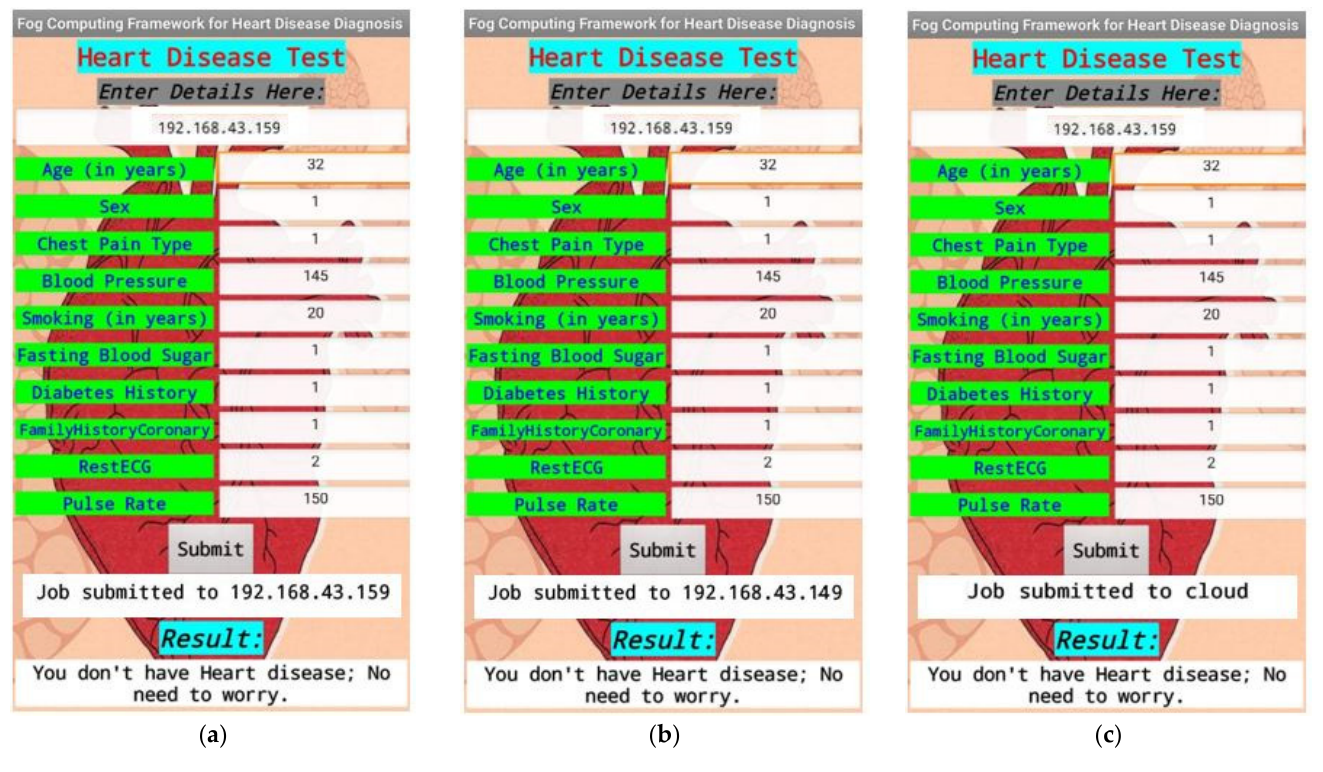
Figure 4. Android app communication with: ( a ) MBP; ( b ) FWN; ( c ) CCN. Table 5. Samples from pre-processed IHDD dataset.